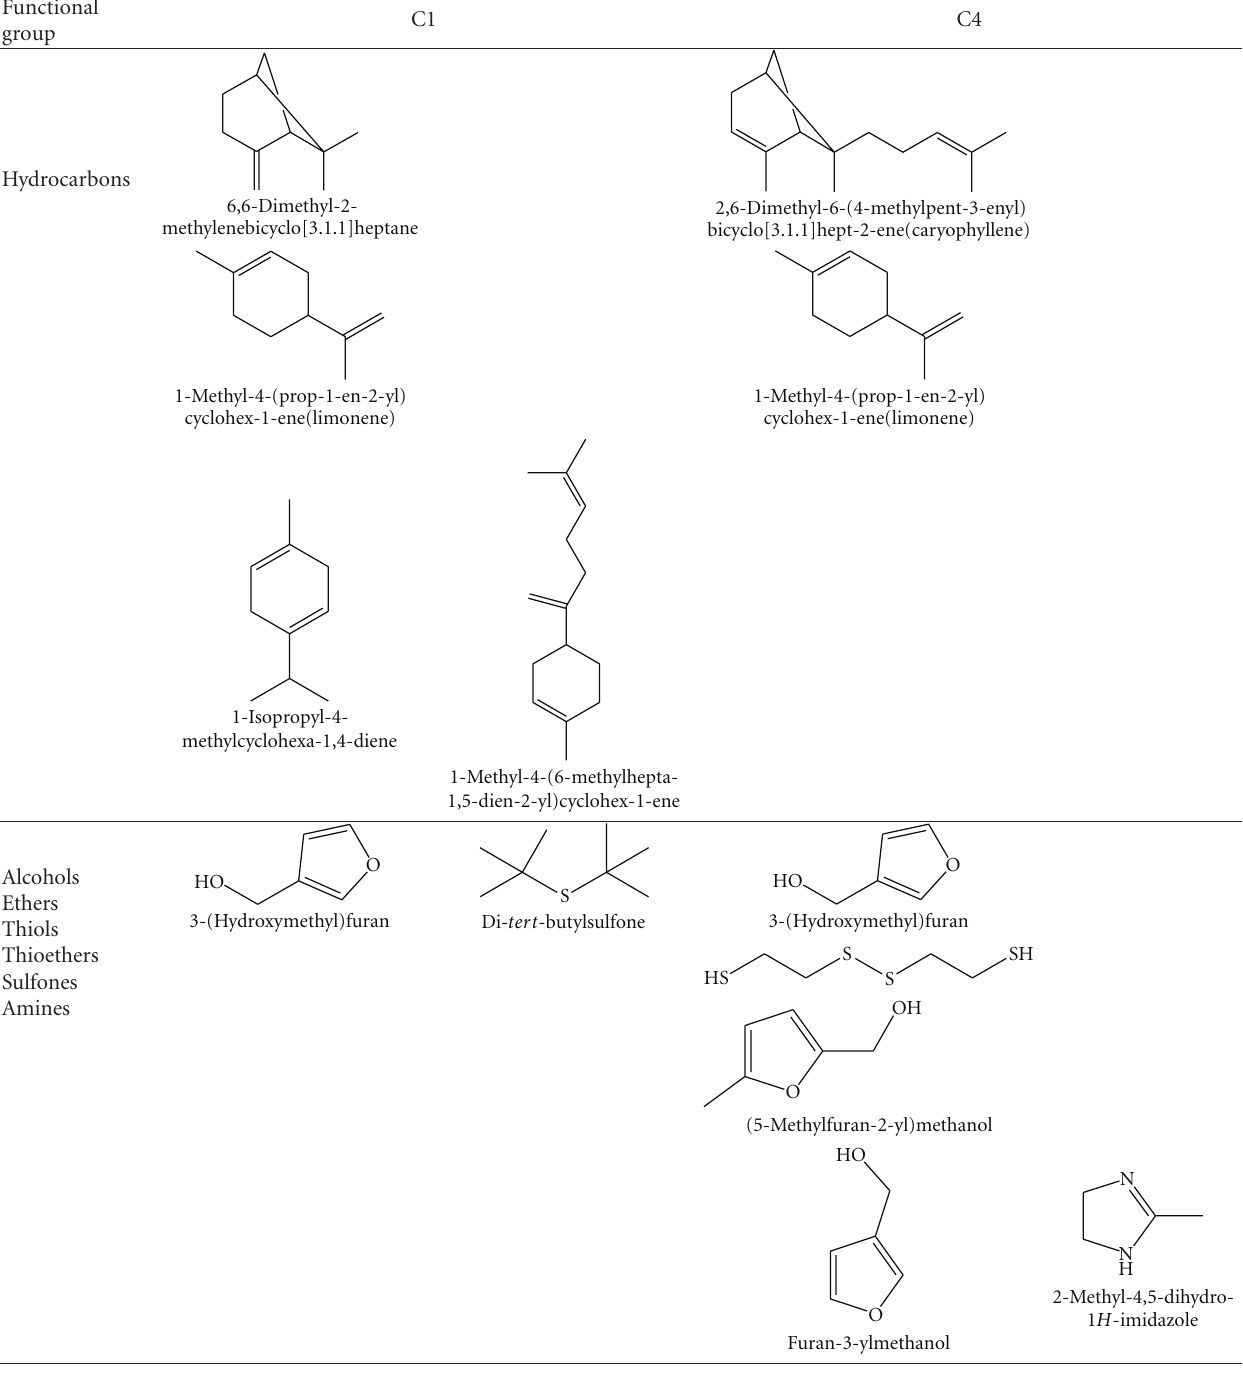
Table 2: Molecular composition of the low-molecular-weight fraction of the extracts from composts C1 and C4. Hydrocarbons, alcohols, thiols, ethers, thioethers, sulfones , and